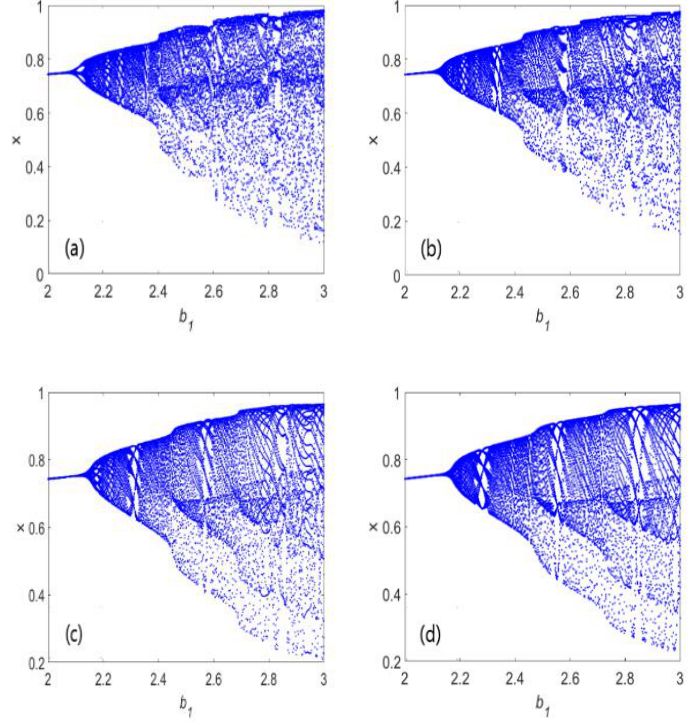
Figure 7. Bifurcation diagrams with the varying parameter b ( d ) α =